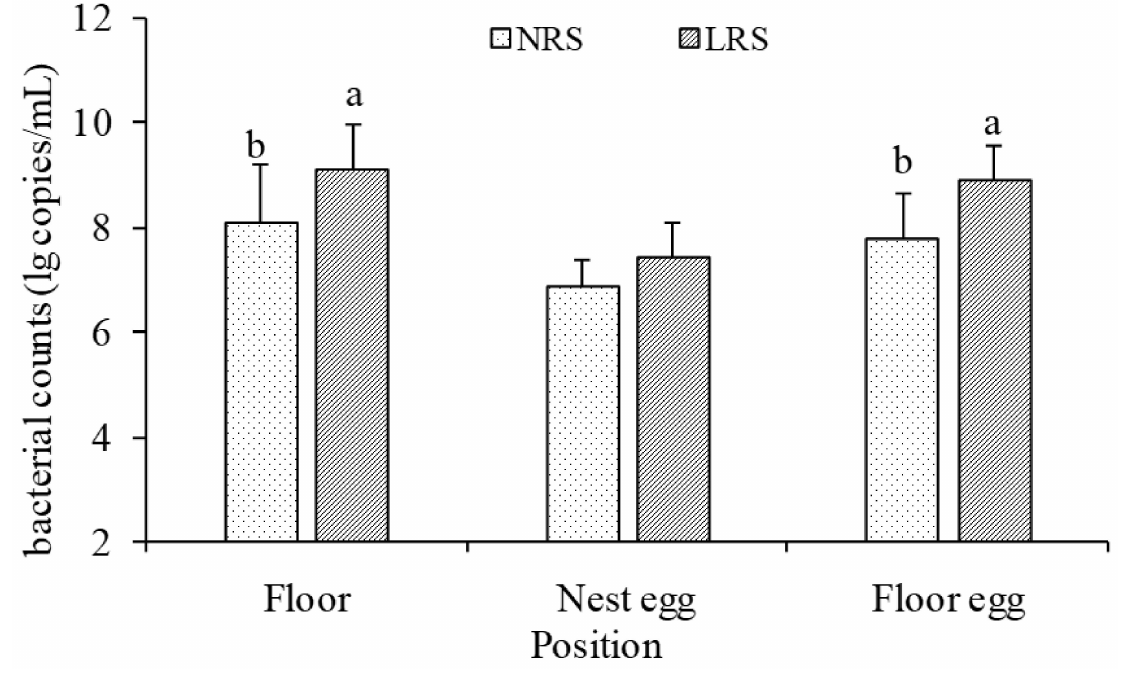
Figure 3. The bacterial counts on the surfaces of the floor, nest eggs and floor eggs in the two housing system houses. NRS, plastic-net housing system; LRS, floor-litter housing system; a,b . Means with different superscripts within each position are significantly different ( p < 0.05). Lines connected above the bars indicate the standard